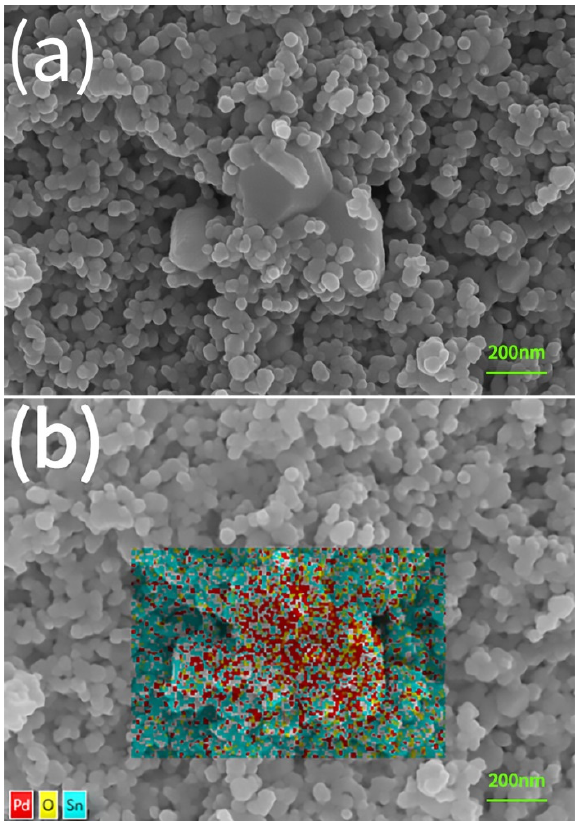
Figure 3. SEM Micrograph analyses for a Pd-SnO 2 nano-ceramic sample of 5 wt% Pd sintered at 950 °C for 2 h in air: ( a ) an SEM micrograph; ( b ) an SEM micrograph with EDS analysis covering its large grains in the center.